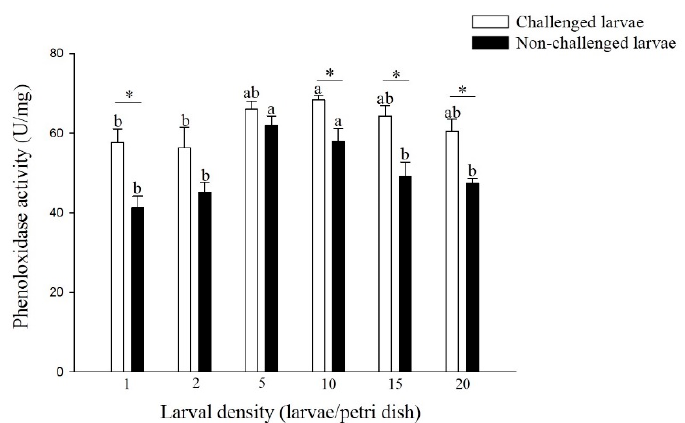
Figure 2. Phenoloxidase (PO) activity of larval P. xylostella reared at different larval densities. Bars of non-challenged (or challenged) larvae with the same letter are not significantly different at the 0.05 level by Tukey’s HSD multiple comparison. The asterisk indicates a significant difference at the 0.05 level by Student’s t -test between the non-challenged and challenged groups.